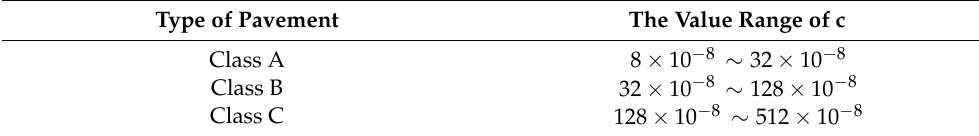
Table 4. The value of c for various road surface